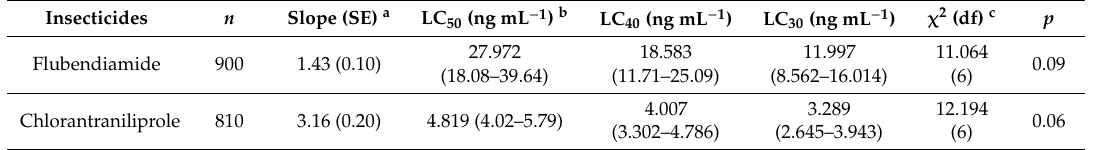
Table 1. Toxicity of flubendiamide and chlorantraniliprole to third instar larvae of Chloridea virescens in diet